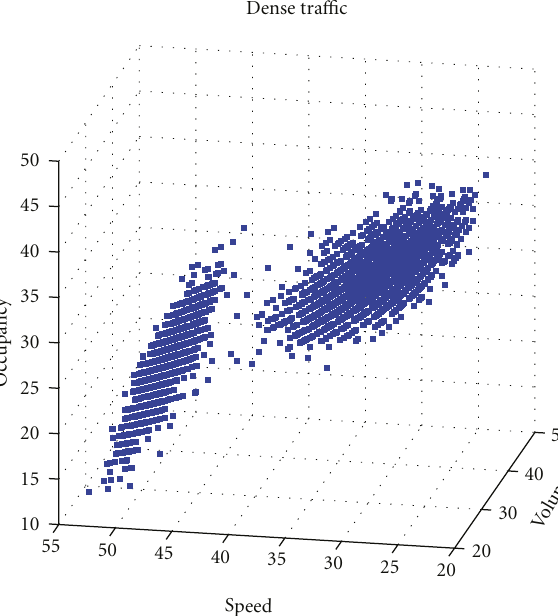
Each ILD sensors generates speed , volume, and occupancy parameters values for configurable one period of time (i.e., 60 seconds) for each lane on the